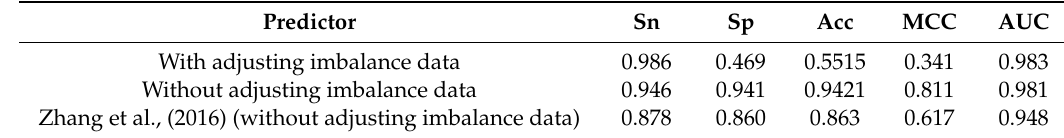
Table 3. Comparison results on the independent dataset